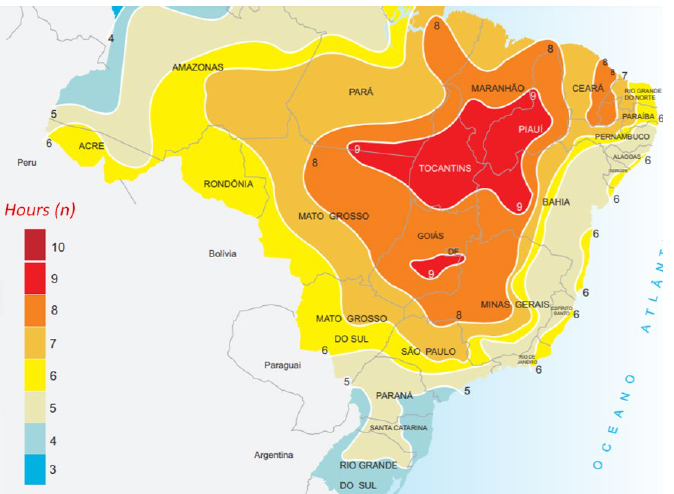
Figure 5. Monthly average daily insolation for the month of June, in Brazil, source: Adapted from [49].